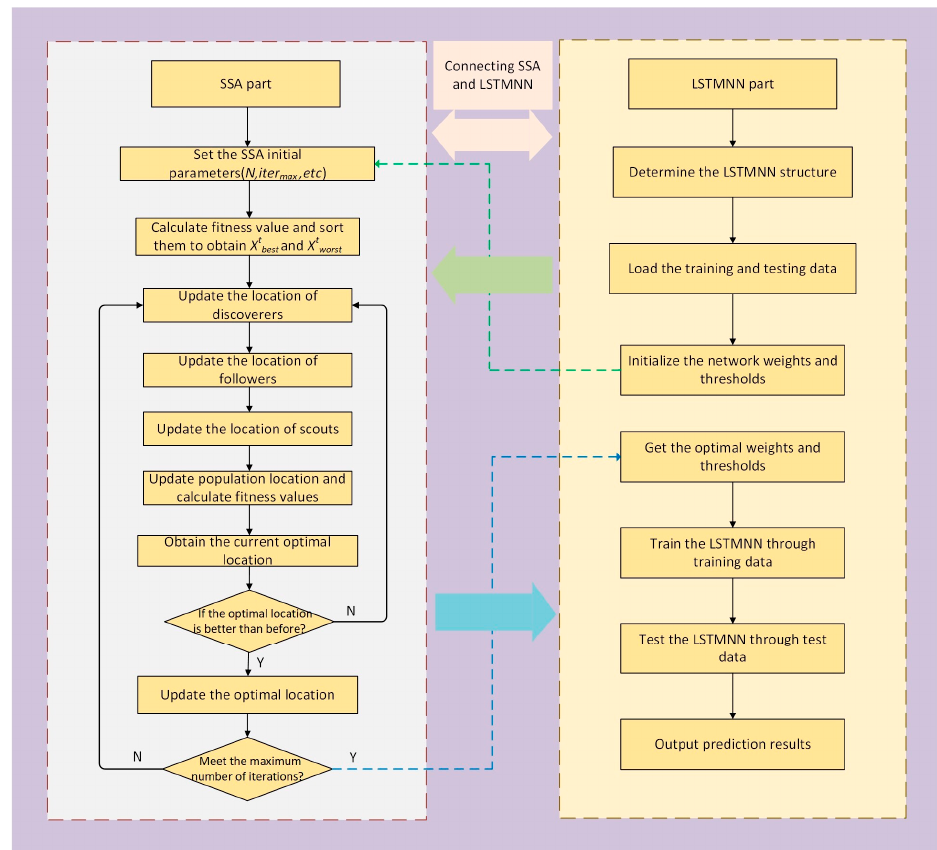
Figure 3. SSA-LSTMNN modeling process 1. Determine the structure of the LSTMNN, prepare the data set, including the test and training set, and initialize the thresholds and parameters of the neural network ran- domly. Initialize the parameters of the PSOA. Set the total number of particle swarm to 30 and the maximum number of iterations to 50.